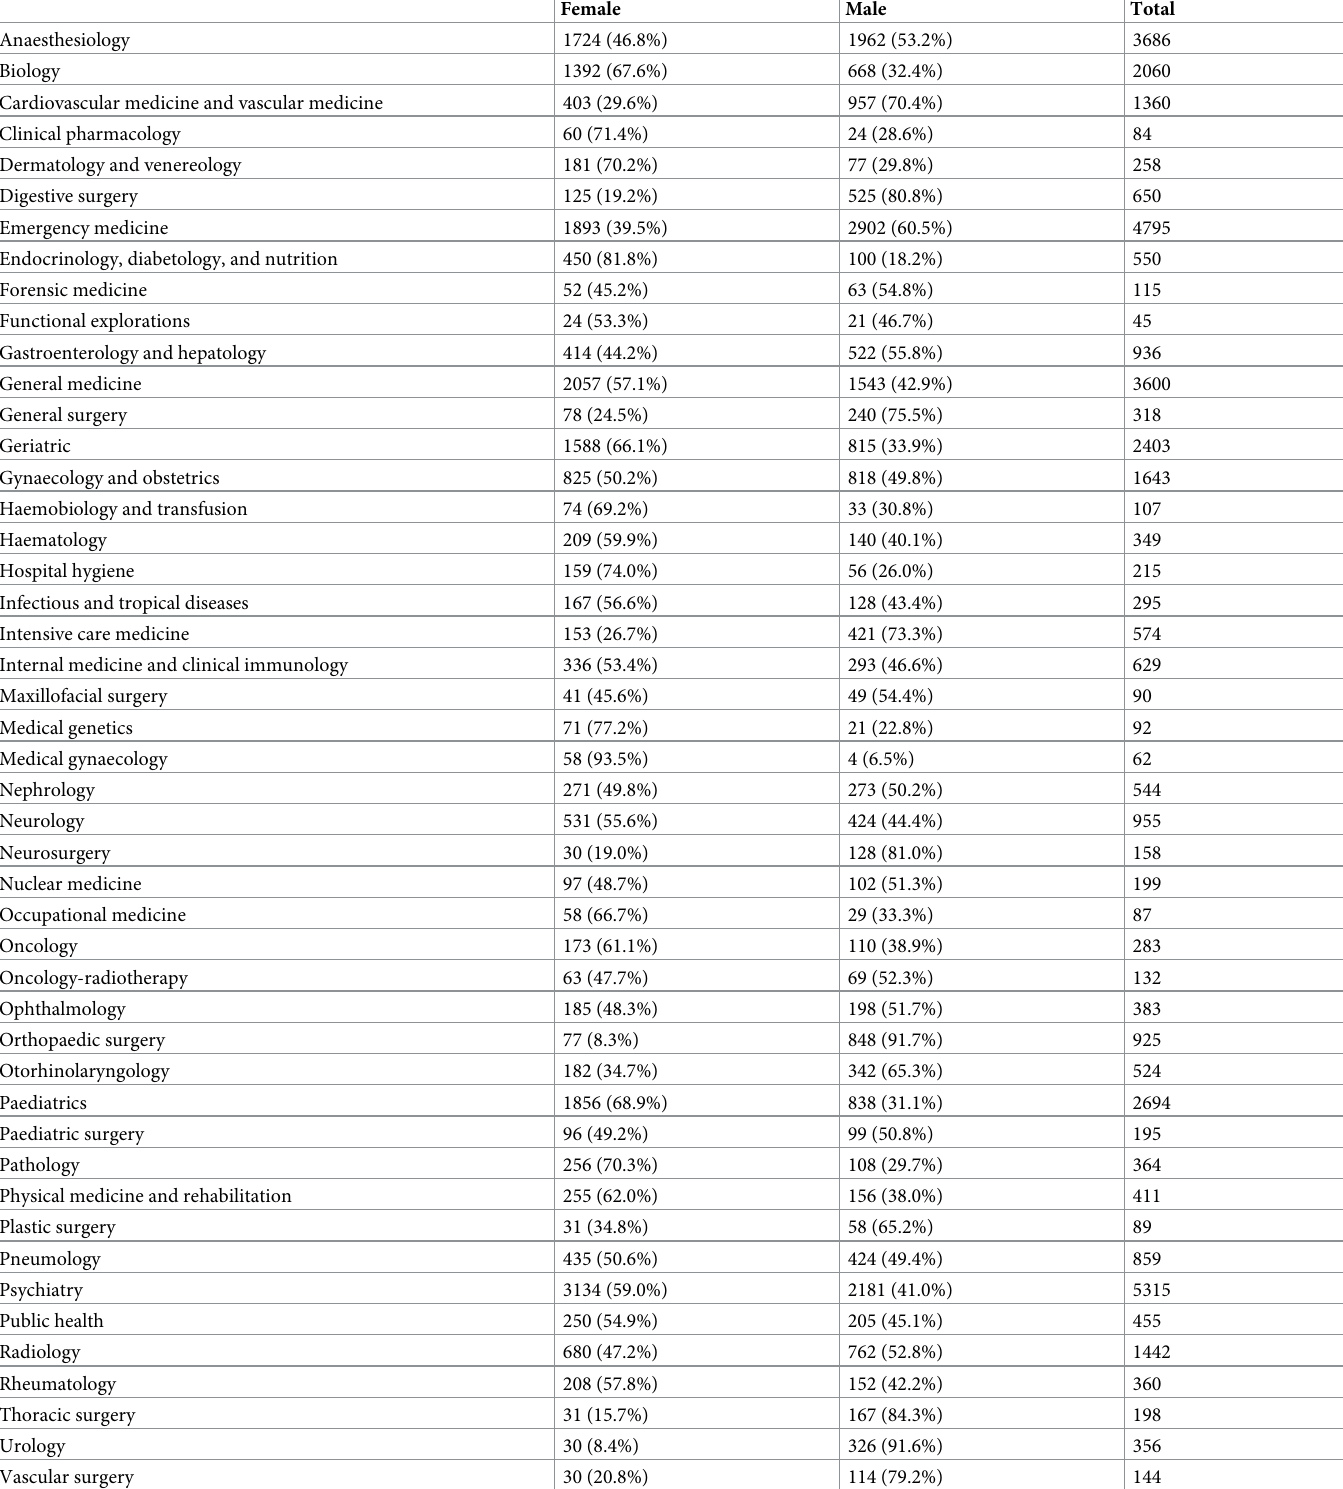
Table 2. Distribution of French medical doctors working as Hospital Practitioners according to specialty and gender in